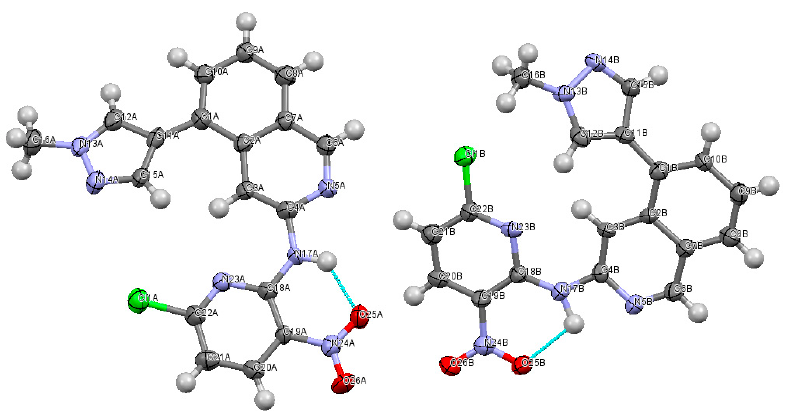
Figure 1. Structure of 1 determined by X-ray crystallography confirming the desired regiochemistry. The structure further demonstrates the formation of an intramolecular hydrogen bond between the nitro group and the diarylamine NH. Two rotamers were observed.